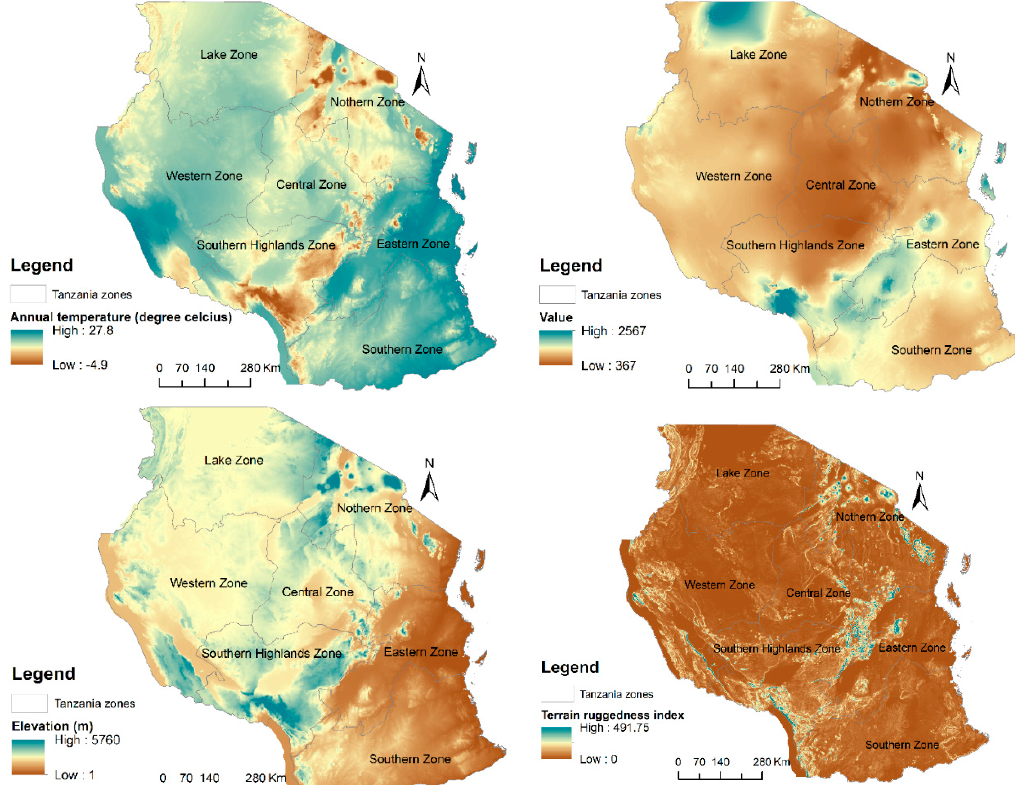
Figure A1. Distribution of the selected environmental variable in the study area .